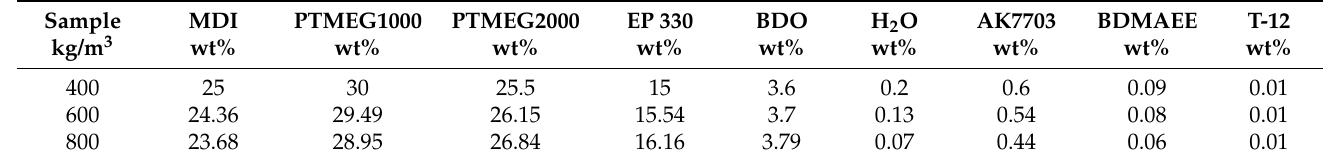
Table 1. The synthetic formula of PUMEs with different